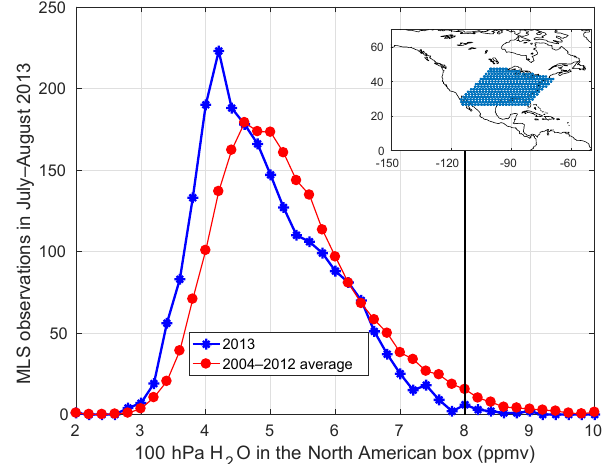
Figure 2. The distribution of JLH Mark2 water vapor in the over- world stratosphere for all flights in the SEAC 4 RS mission (summer 2013) plotted as a fraction of the observations in each potential tem- perature range. The first trace (black circles and line) is at potential temperatures of 380 to 400K, corresponding to approximately 16.8 to 17.4km of altitude (99 to 90hPa). The second trace (red triangles and line) is at potential temperatures of 400 to 420K, corresponding to approximately 17.4 to 18.0km of altitude (90 to 80hPa).